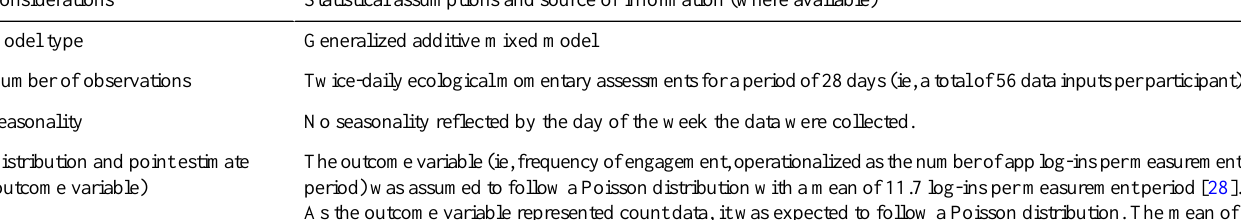
Table 1. Statistical assumptions used to inform the simulation-based power analysis. Statistical assumptions and source of information (where available)Considerations Generalized additive mixed modelModel